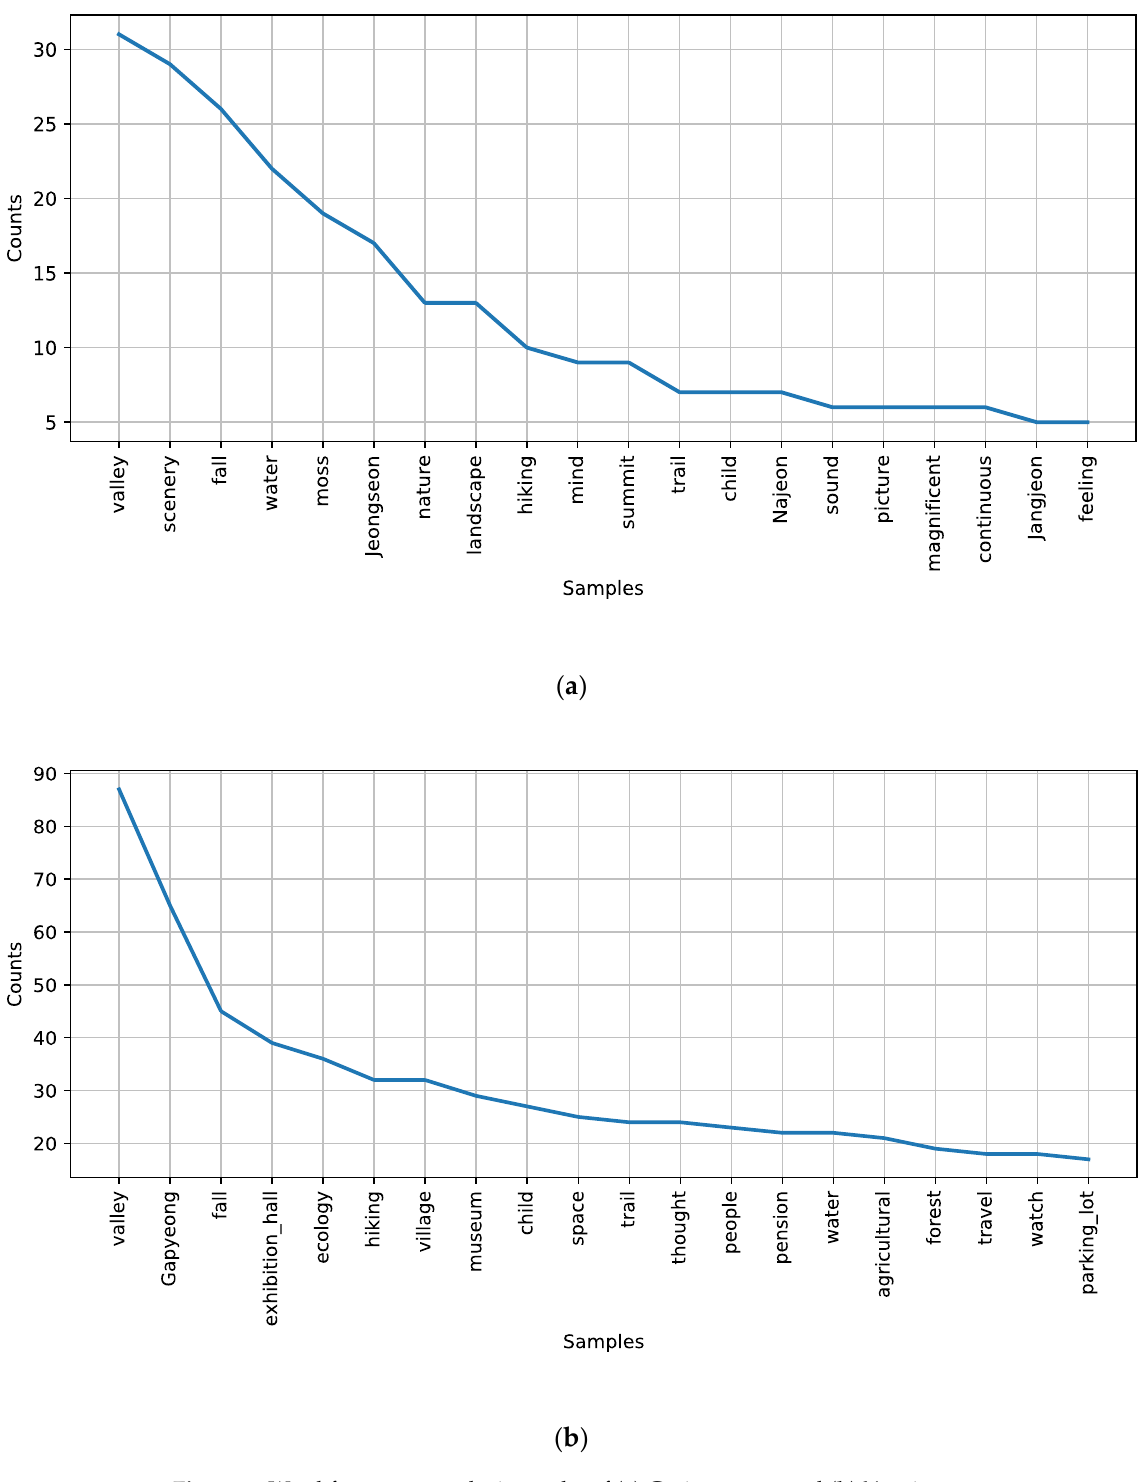
Figure 7. Word frequency analysis results of ( a ) Gariwangsan and ( b ) Yeoninsan.